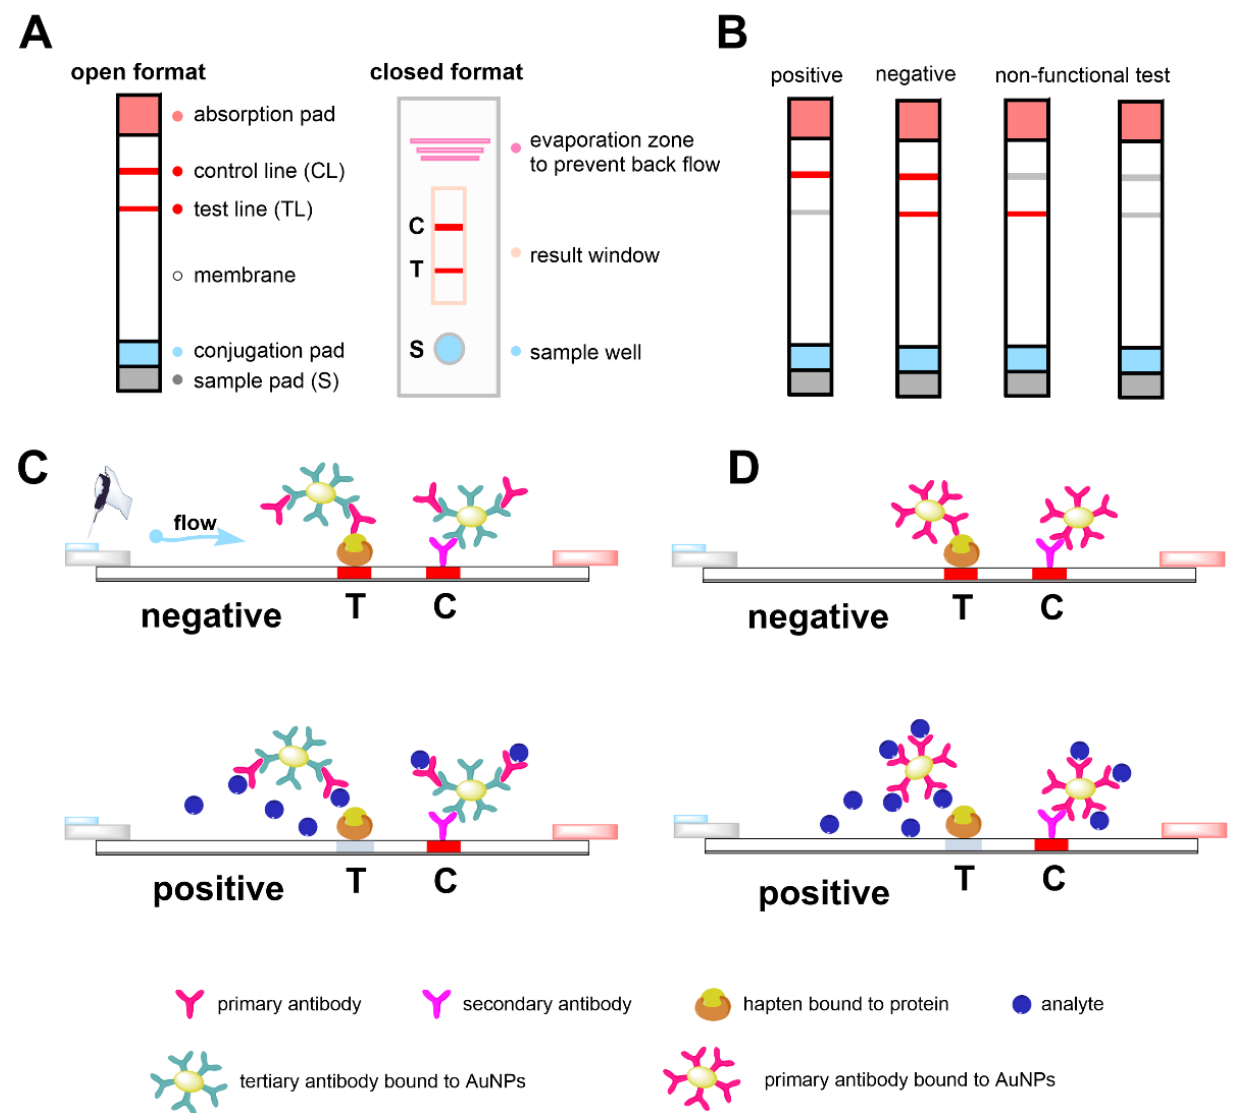
Figure 2. Test strips of immunochromatographic test (ICT) in competitive arrangement. Description of individual parts and representation of opened and closed format on panel ( A ); test results on panel ( B ); representation of indirect and direct ICT format on panels ( C , D ), respectively.